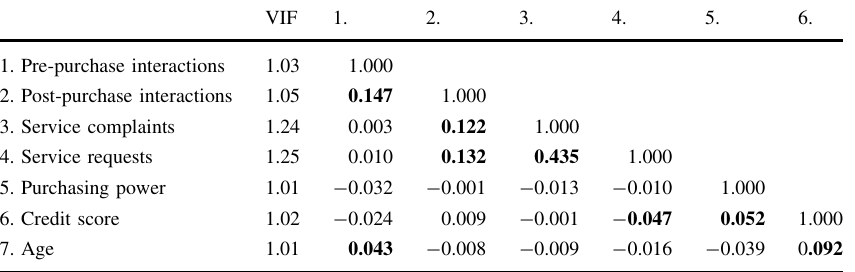
Table 11 Correlations for matched sample